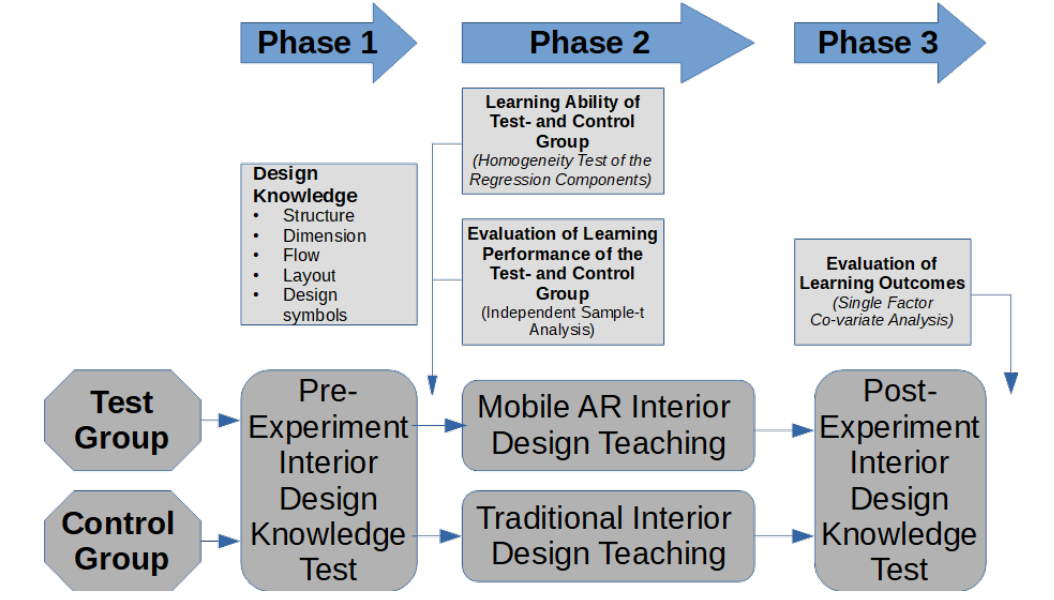
Figure 4. The three stages (phases) of our experiment.